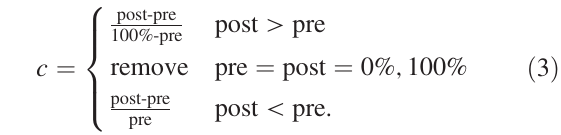
knowledge, Axis 2: Nature of knowing and learning, Axis 3: Real-life applicability, Axis 4: Evolving knowledge, Axis 5: Source of ability to